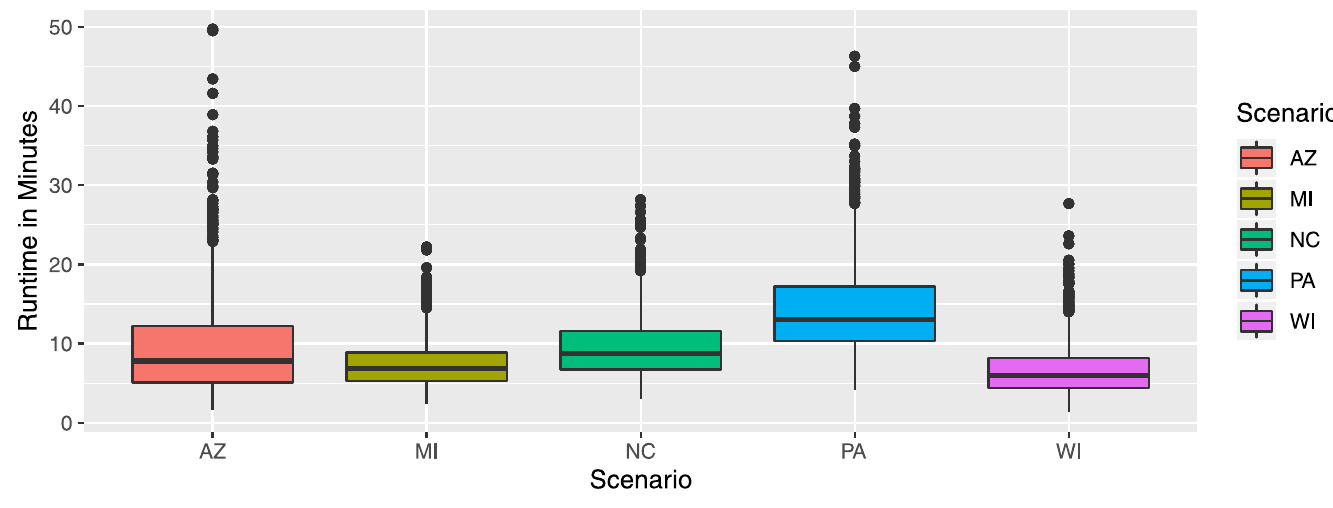
Fig 1. Run time in minutes for districting plans based on the US